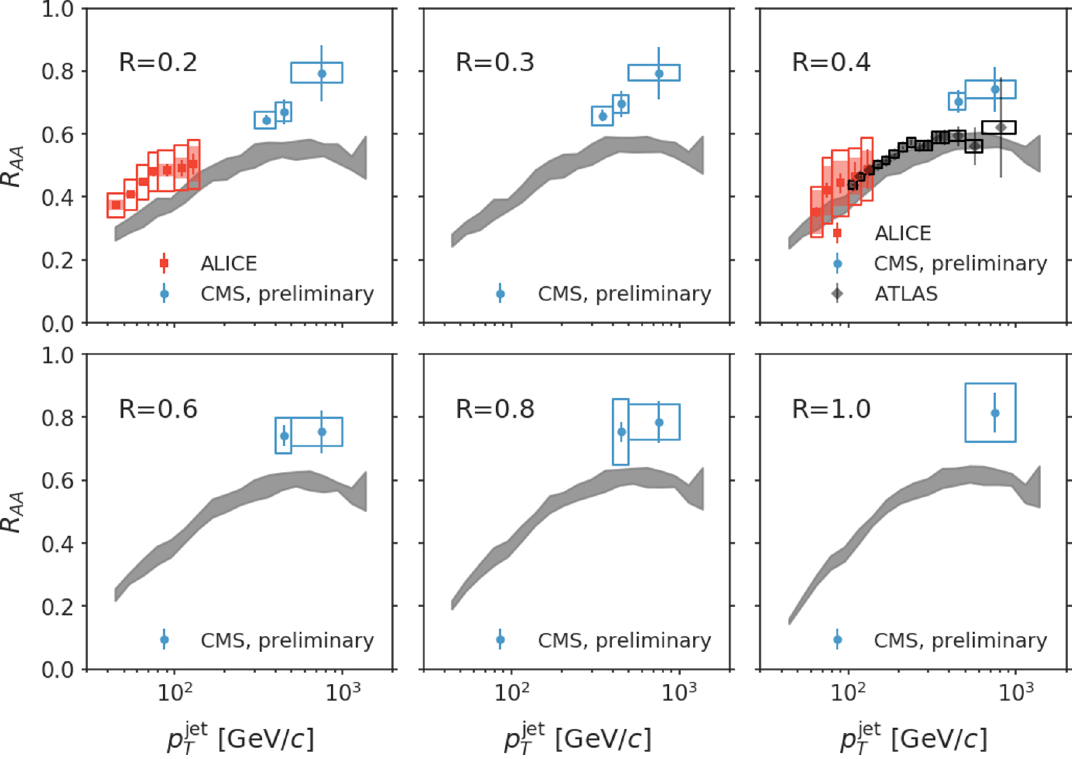
Figure 12 . Predictions of cone-size dependence of inclusive jet nuclear modification factor in Pb-Pb √ collisions at s NN = 5 . 02 TeV, as compared to data from ALICE [91] and ATLAS [90] experiments, and preliminary data from the CMS experiment